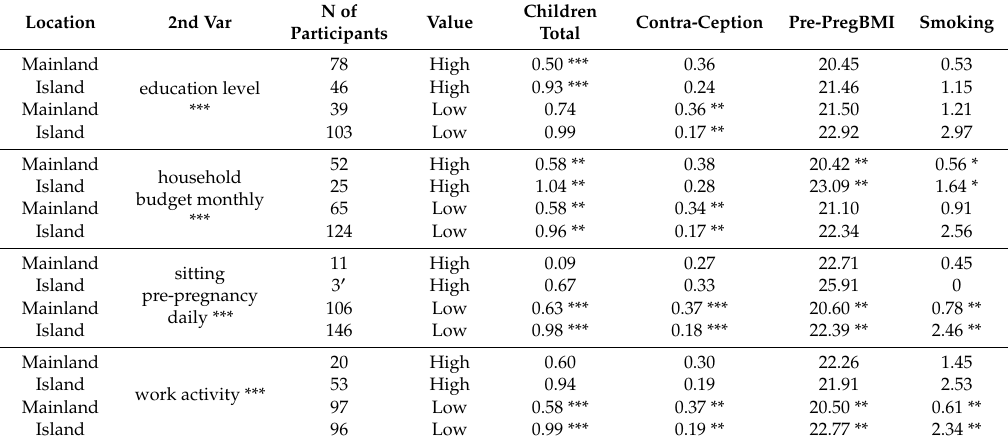
Table 3. Di ff erences in maternal socioeconomic factors and lifestyle with regards to location (mean values are converted to high-low values with level of significance for the location tested by the